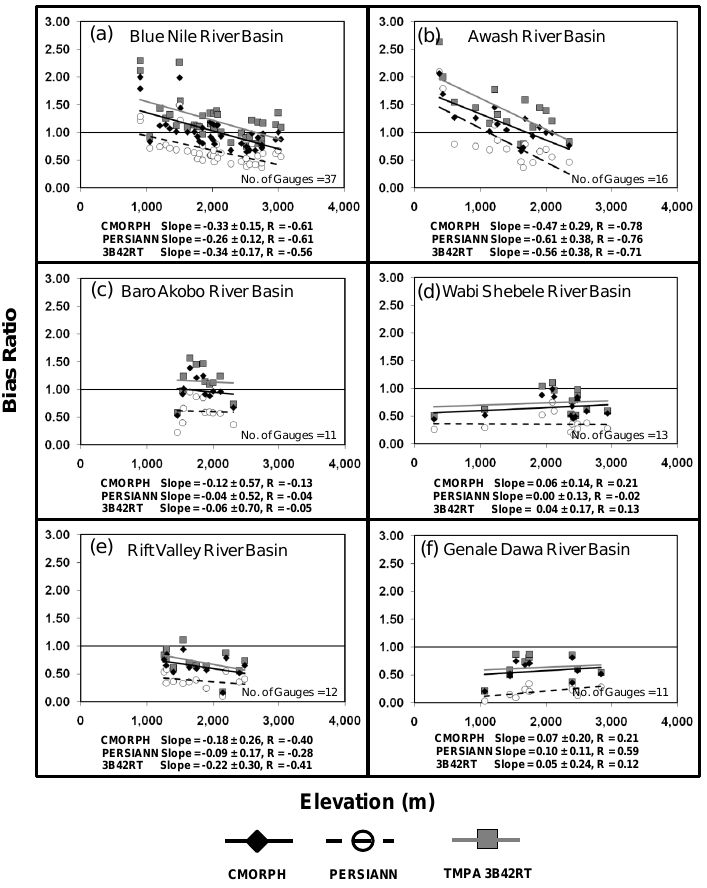
Fig. 5. Bias Ratio vs. Elevation for the Major Rainy Season Figure 5 – Bias Ratio vs. Elevation for the Major Rainy Season (Kiremt)